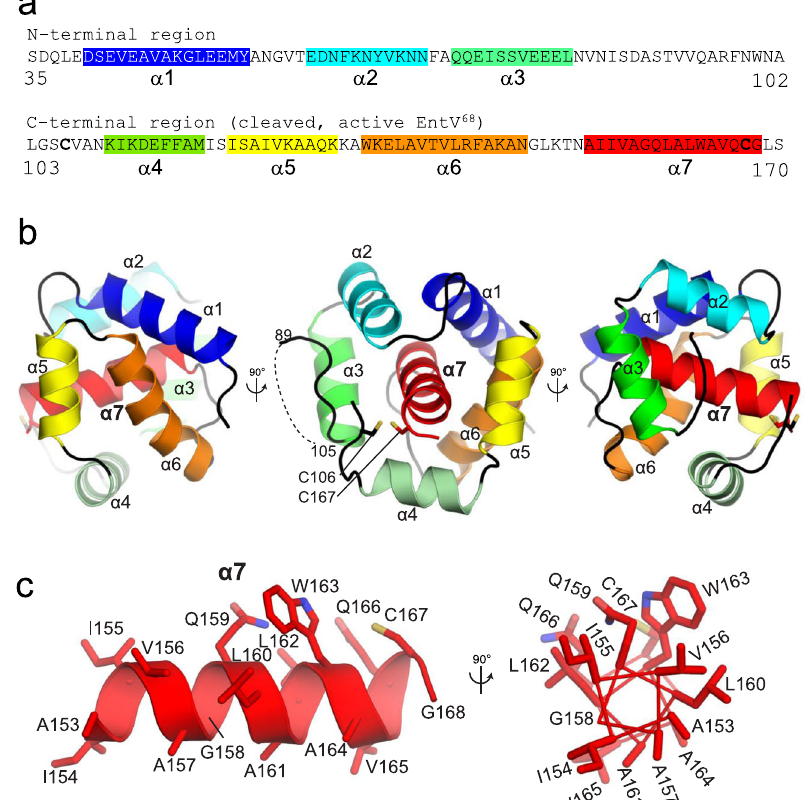
Fig. 1 | The sequence and structure of EntV. a The sequence of full-length, secretedEntV 136 .ThesecondlineisEntV 68 ,theactiveformoftheproteingenerated following cleavage. The highlighted sequences and their colors correspond to the